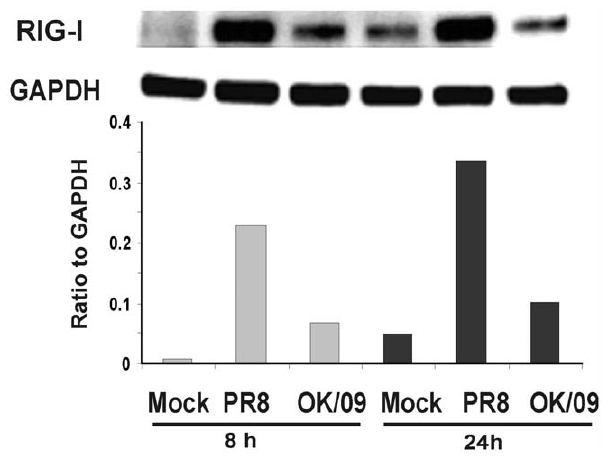
Figure 4. Pandemic OK/09 induces lower RIG-I protein responses than PR8 in human lung. Human lung slices were exposed to 6 6 10 6 PFU/ml of PR8 or OK/09 for 8 h and 24 h. Western blot analysis was used to determine RIG-I protein expression in lung slices. Membranes were probed with anti-RIG-I or anti-GAPDH antibodies. Protein expression of RIG-I was normalized relative to GAPDH. Data are representative of 3 separate experiments.